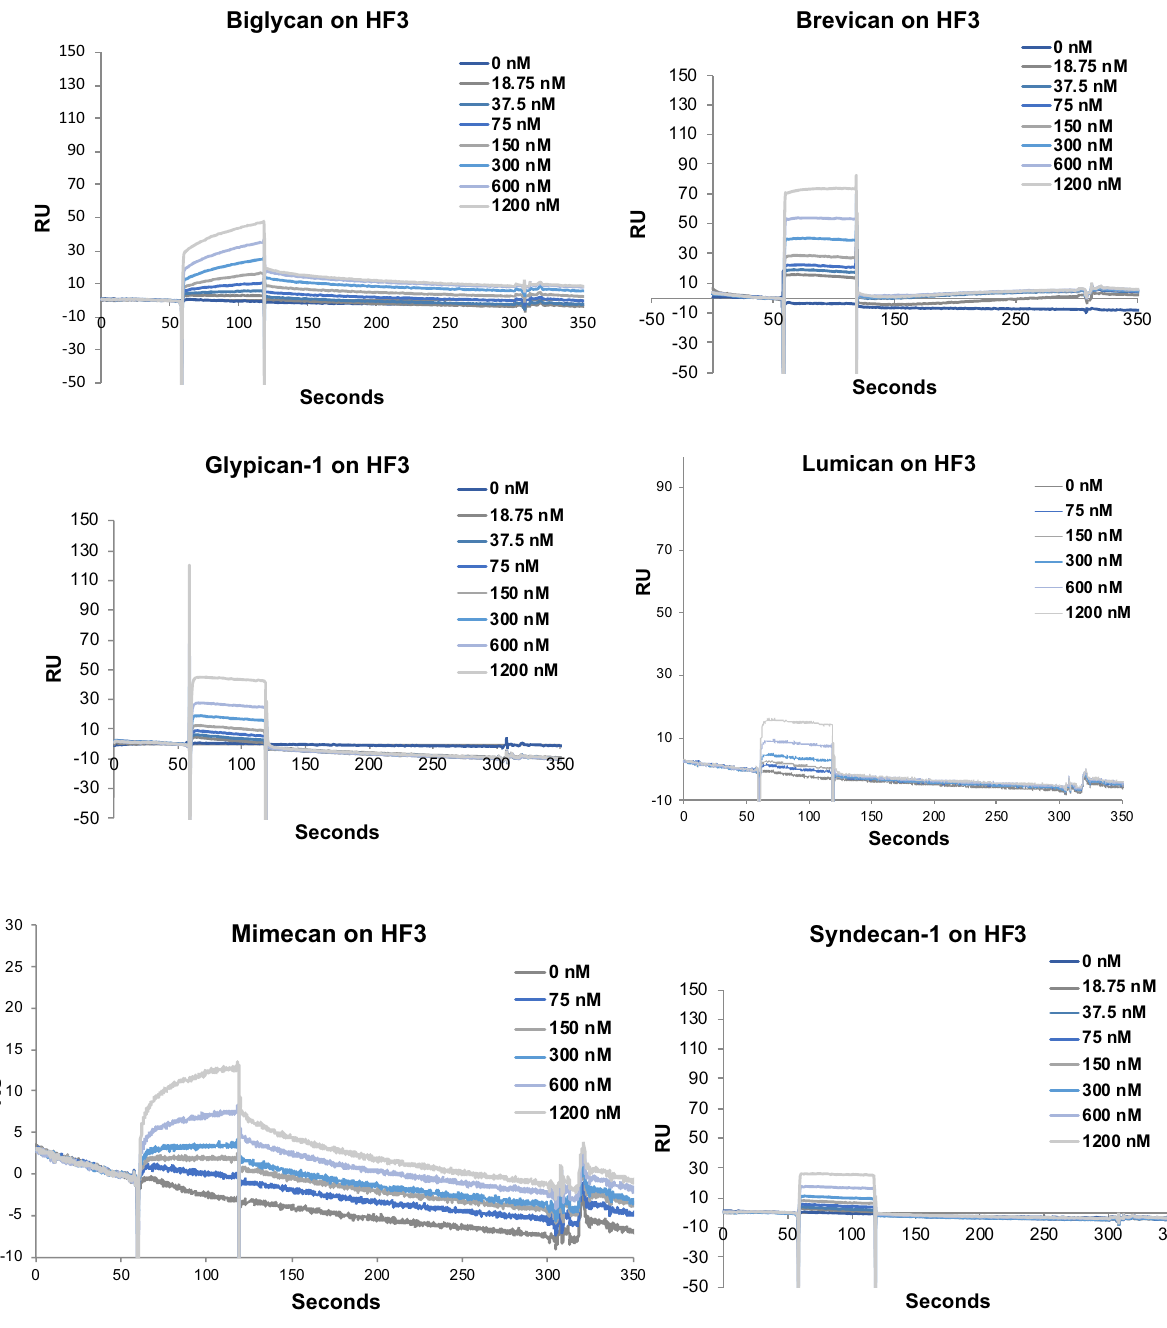
Figure 1. Interaction of HF3 with proteoglycans by surface plasmon resonance, using a Biacore T100 system. Proteoglycans were injected over immobilized HF3, at the indicated concentrations, as described in experimental